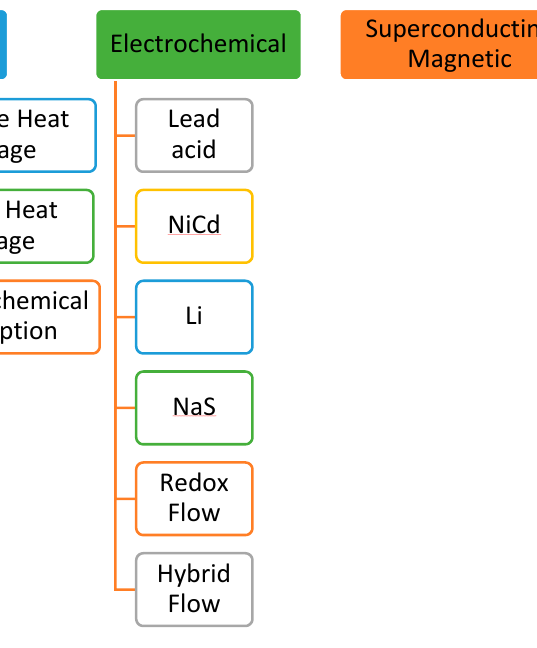
Figure 2. Classification of EES based on type of energy consumed.